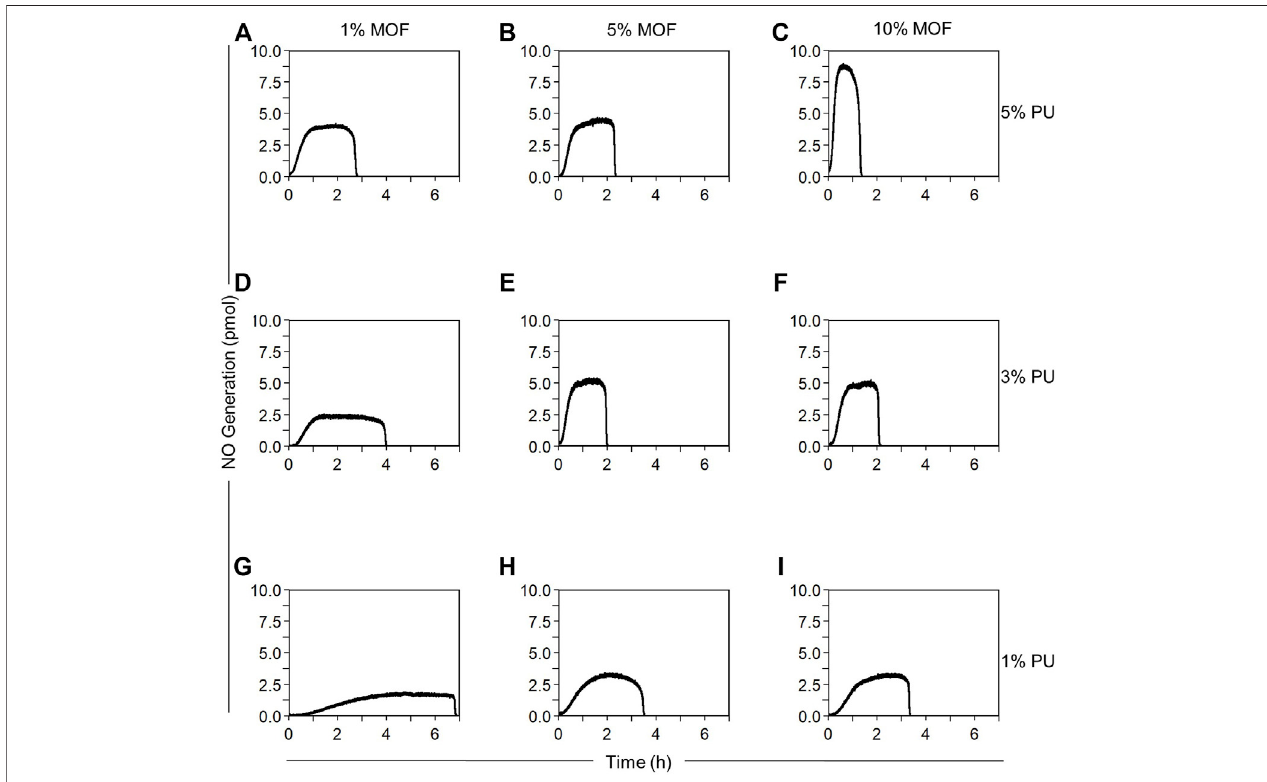
FIGURE 2 | Representative NO release pro fi les as a function of MOF loading and PU concentration. Composite fabricated with: (A) 1 wt.% MOF, 5 w/v% PU, (B) 5 wt.% MOF, 5 w/v% PU, (C) 10 wt.% MOF, 5 w/v% PU, (D) 1 wt.% MOF, 3 w/v% PU, (E) 5 wt.% MOF, 3 w/v% MOF, (F) 10 wt.% MOF, 3 w/v% MOF, (G) 1 wt.% MOF, 1 w/v% PU, (H) 5 wt.% MOF, 1 w/v% PU, (I) 10 wt.% MOF, 1 w/v% PU. Experiments conducted using the NOA in ultrapure water with constant N 2 bubbling at 25 ° C shielded from light with 10 × 10 – 6 M GSNO. Composites (1.2 cm diameter) fabricated with ground MOF. Data reported as mean ± SD ( n =